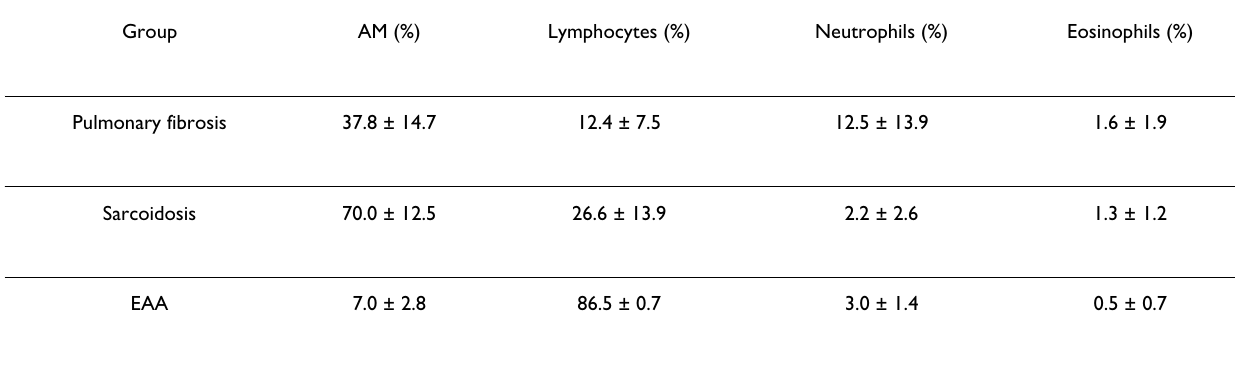
Table 2: Differential BAL cell counts in different patient